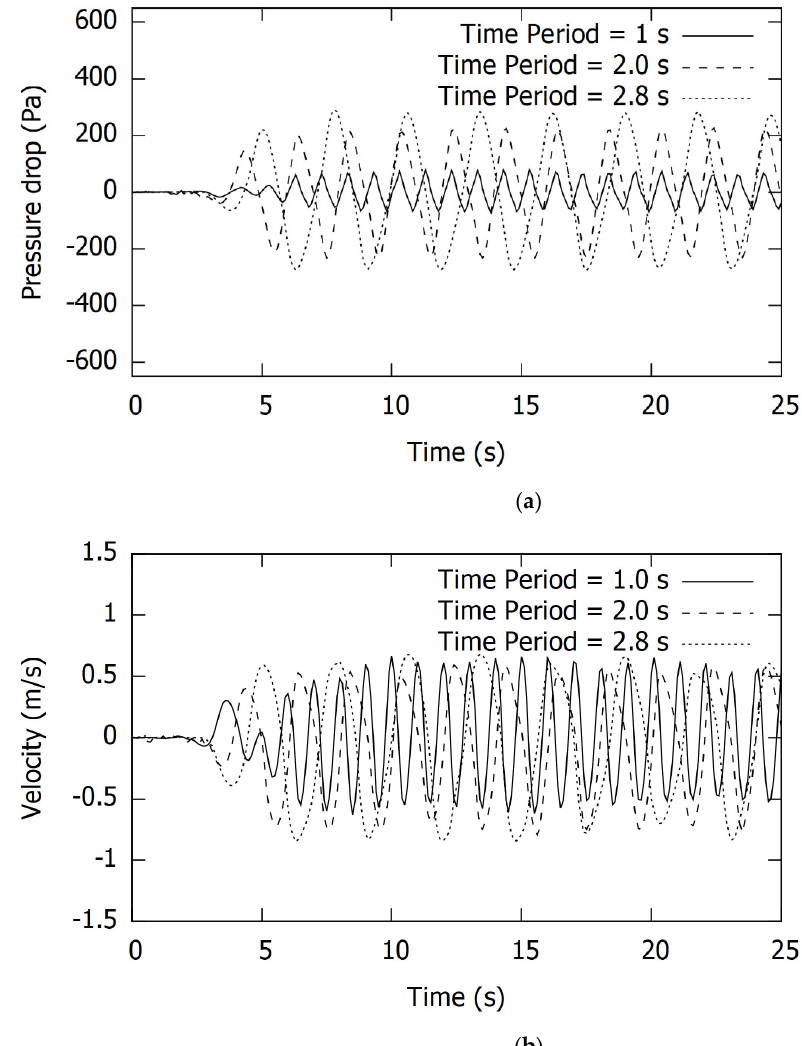
Figure 7. Effects of time period on the ( a ) pressure drop across the pipe ( b ) velocity through the orifice.